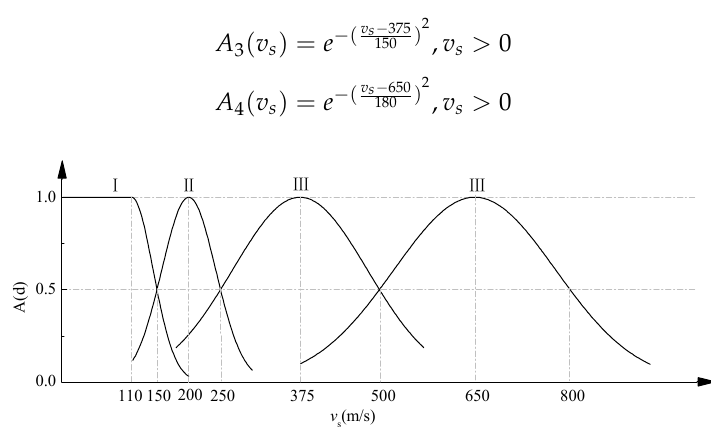
Figure 2. Membership function of mean shear wave velocity.